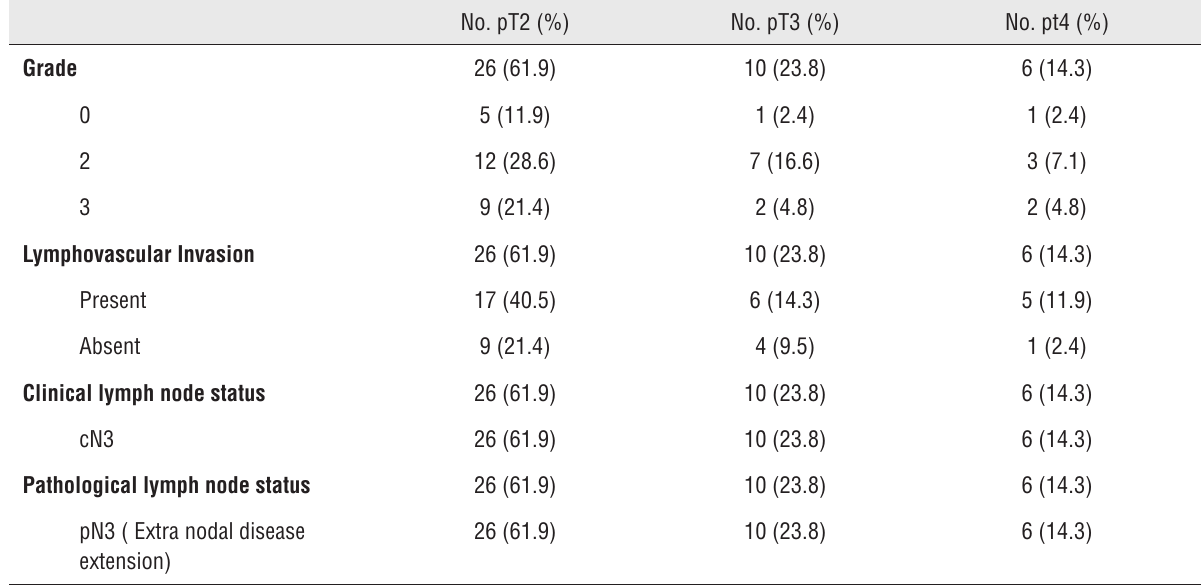
Table 1 - Clinical and pathological characteristics of primary penile tumor and lymph node status in 42 patients undergoing bilateral PRISD and unilateral PRISD with contralateral